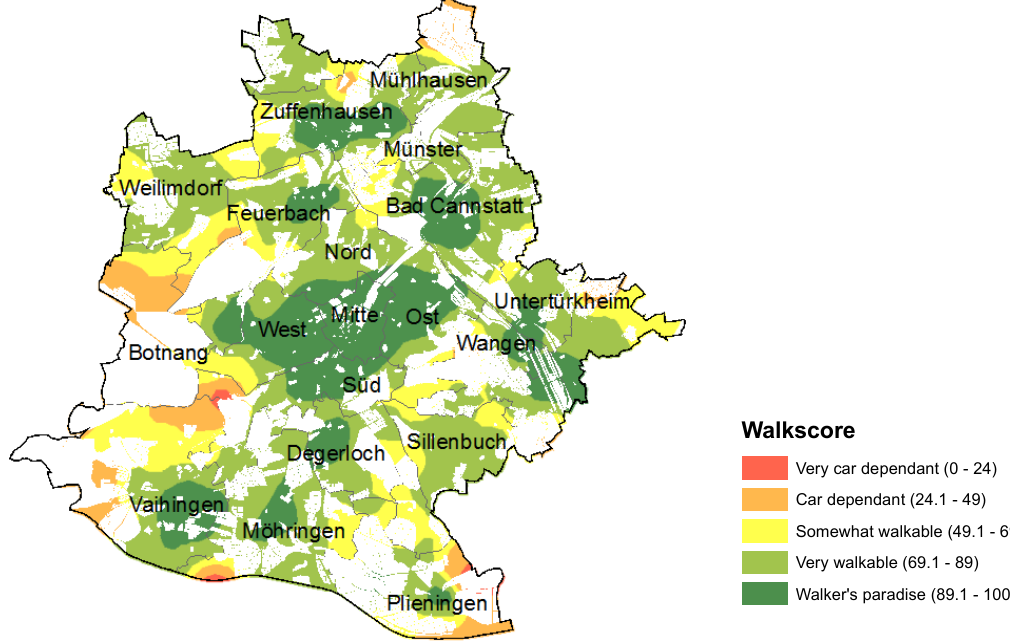
Figure 3. Walk Score for